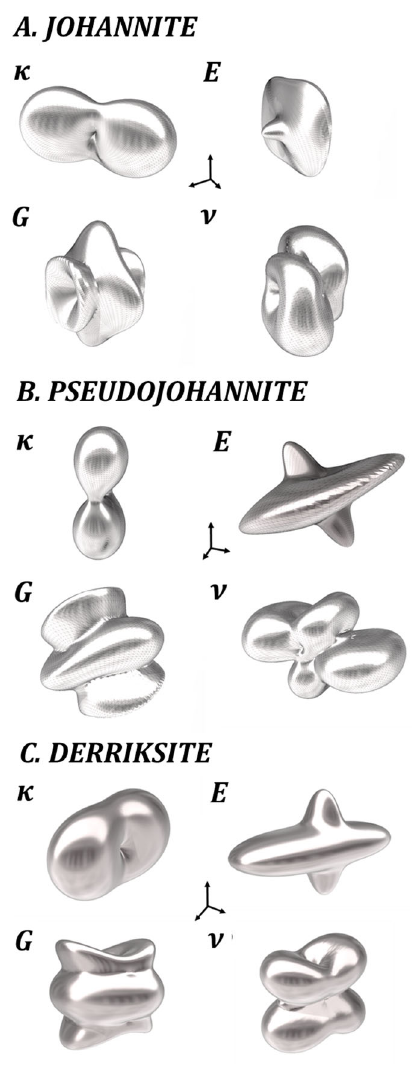
Figure 9. Elastic properties of ( A ) johannite, ( B ) pseudojohannite and ( C ) derriksite minerals as a function of the orientation of the applied strain: ( κ ) Compressibility; ( E ) Young’s modulus; ( G ) Shear modulus; ( ν ) Poisson’s ratio. The largest values of the compressibility, Young’s mod- ulus, shear modulus and Poisson’s ratio are 36.42 TPa − 1 , 45.35 GPa, 27.59 GPa and 0.87 for johannite, 19.98 TPa − 1 , 91.59 GPa, 35.37 GPa and 0.93, for pseudojohannite, and 17.03 TPa − 1 , 31.06 GPa, 26.39 GPa and 0.66 for derriksite,